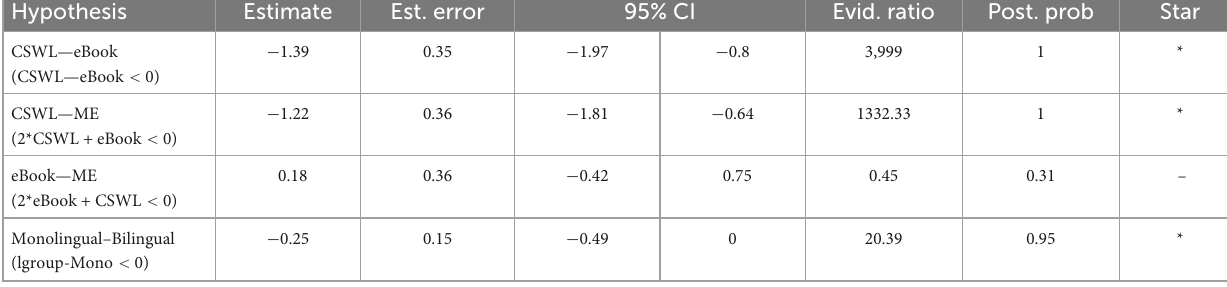
TABLE 2 Summary of directional hypotheses tests for the effects in the Condition*lgroup summed Model as per standard notation used in R. Hypothesis Estimate Est. error 95% CI Evid. ratio Post.